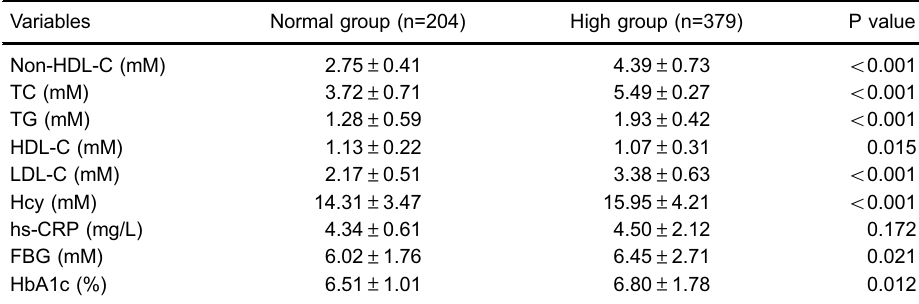
Table 2. Comparison of serum biochemical parameters between normal and high non-high-density lipoprotein cholesterol groups. Variables